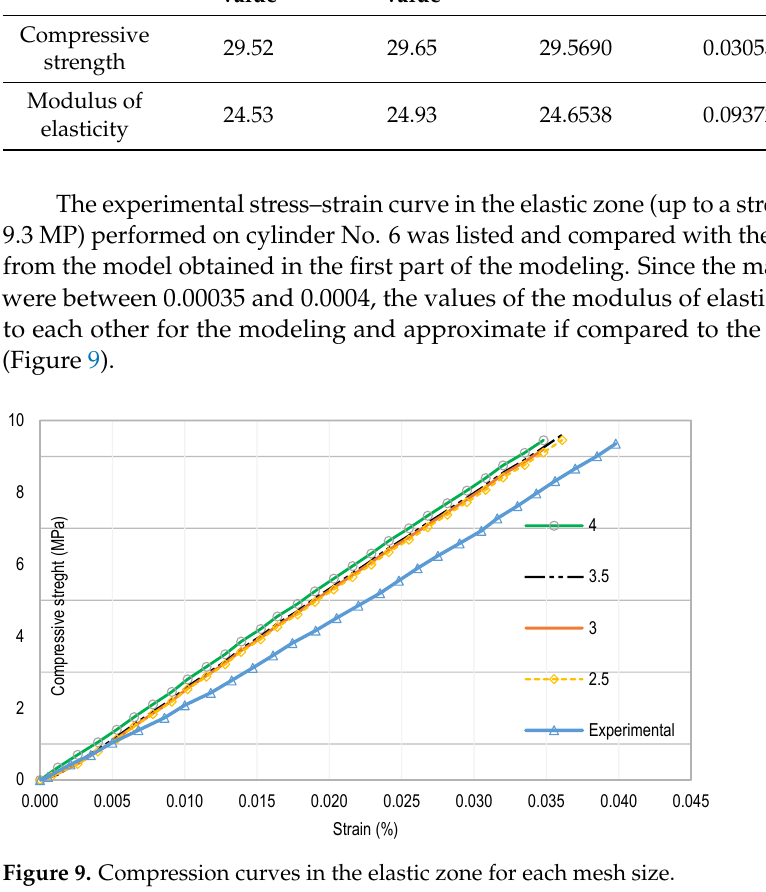
Table 9. Descriptive statistics. Figure 8. Modeling results vs. experimental value. Compressive strength.